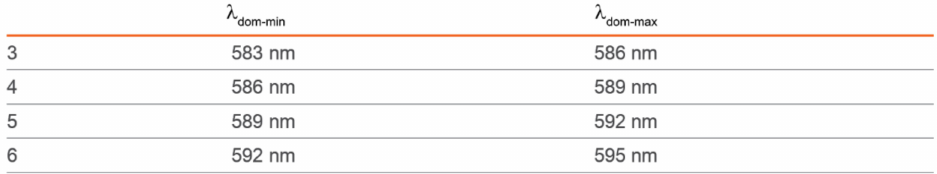
Figure 5. Wavelength groups of LY E6SF LEDs. These wavelengths are relative to the bias current i F = 50 mA and temperature T = 25 ◦ C. The wavelength is typically measured at a current pulse of 25 ms, with an expanded uncertainty of ± 1 nm